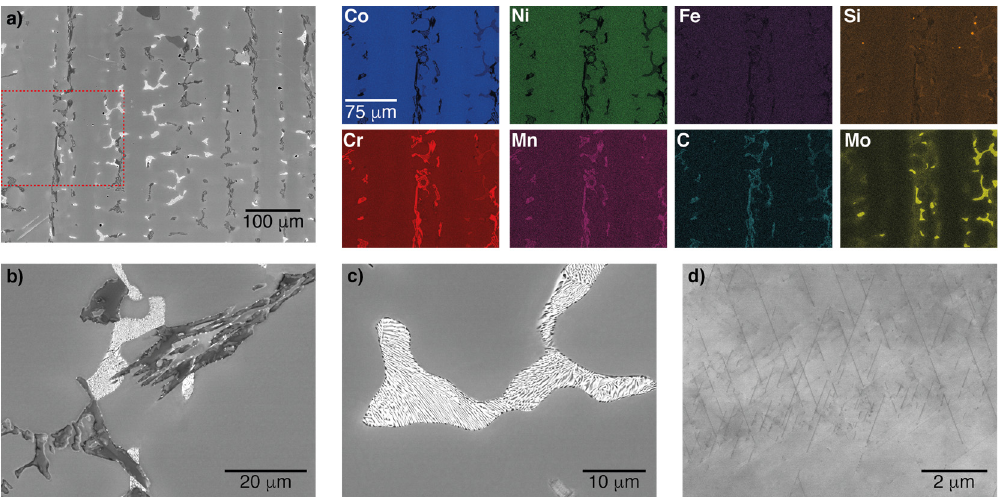
Figure 1. BSE micrographs of Co-101 in the as-cast state. ( a ) low magnification image showing the dendritic microstructure, ( b ) region containing the dark contrast M 7 C 3 constituent, ( c ) region of the lamella intergrowth of the dark M 7 C 3 and bright contrast M 23 C 6 phases, and ( d ) the needle-like features surrounded by the γ matrix. EDX elemental distribution maps of Co, Ni, Fe, Si, Cr, Mn, C, and Mo are shown, taken from the highlighted region in ( a ).